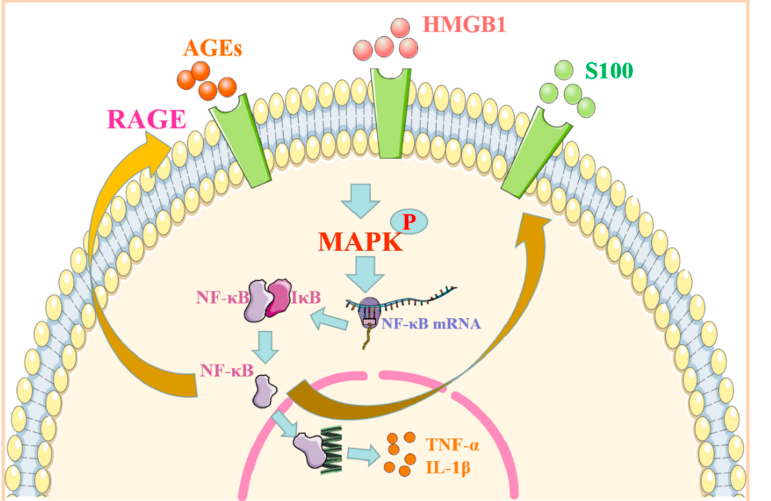
Figure 2. RAGE regulates the MAPK/NF- κ B signaling pathway. After binding to the ligand, RAGE phosphorylates its downstream MAPK and activates NF- κ B protein. NF- κ B enters the nucleus to promote the transcriptional expression of inflammatory factors. Abbreviations: AGEs: advanced glycation end products; HMGB1: high-mobility group protein 1; RAGE: receptor for advanced glycation end products; MAPK: mitogen-activated protein kinase; NF- κ B: nuclear factor kappa-B; TNF- α : tumor necrosis factor α ; IL-1 β : interleukin-1 β . Table 1. The role of RAGE-related signaling pathways in immune-associated diseases. Signal Pathway Ligand Specificity Reaction Diseases